Question: In one sentence, what is this figure communicating?
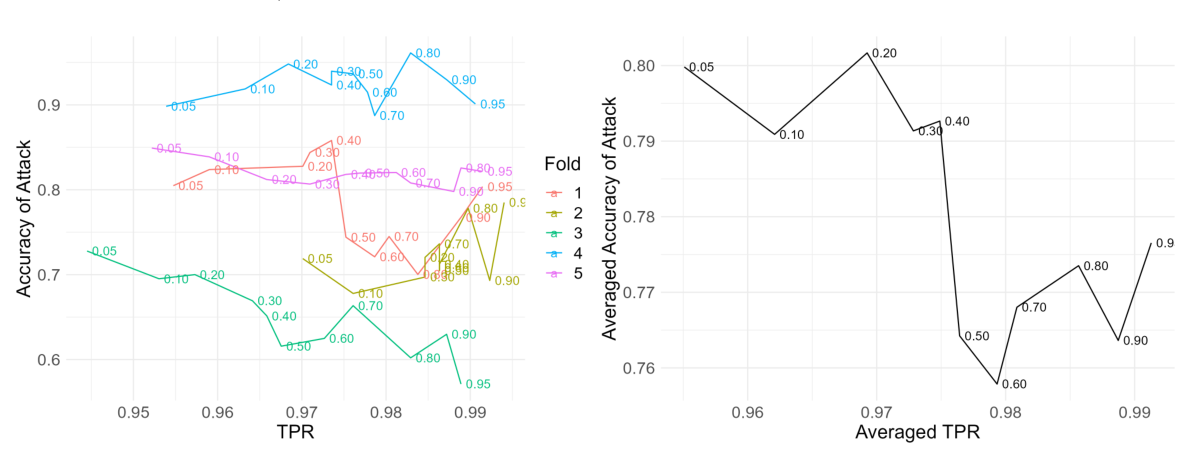
Answer: TPR versus Accuracy of Attack across Thresholds {0.05, 0.1, 0.2, . . . , 0.8, 0.9, 0.95} (la- beled next to the lines) for PD Plots of Race, COMPAS Data